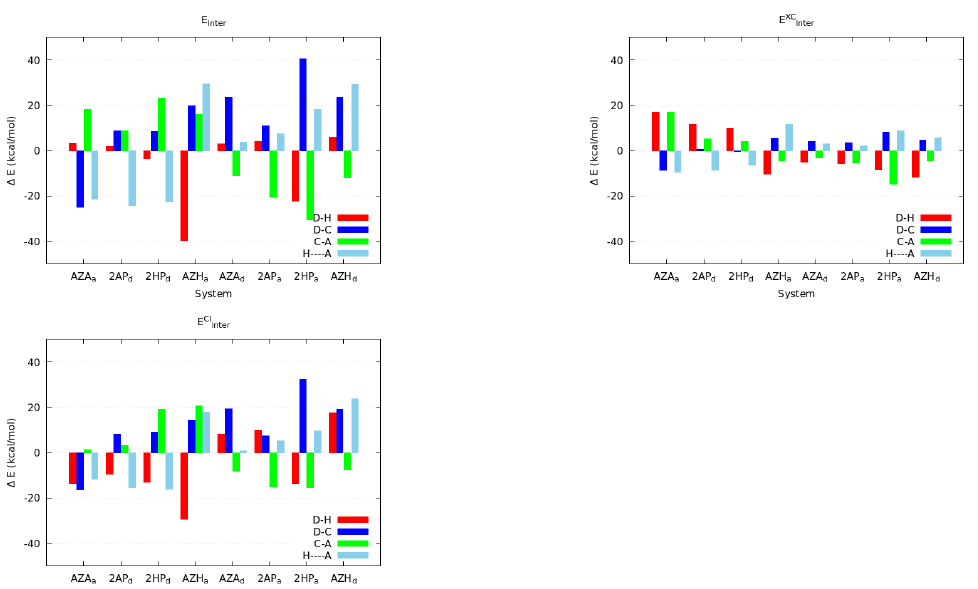
Figure 8. Relative changes in the IQA interaction energies upon dimerisation, all of the values are reported relative to their NCO or NCN reference systems. The tautomeric forms ACR and DCR are indicated by the a and d subscripts, respectively.